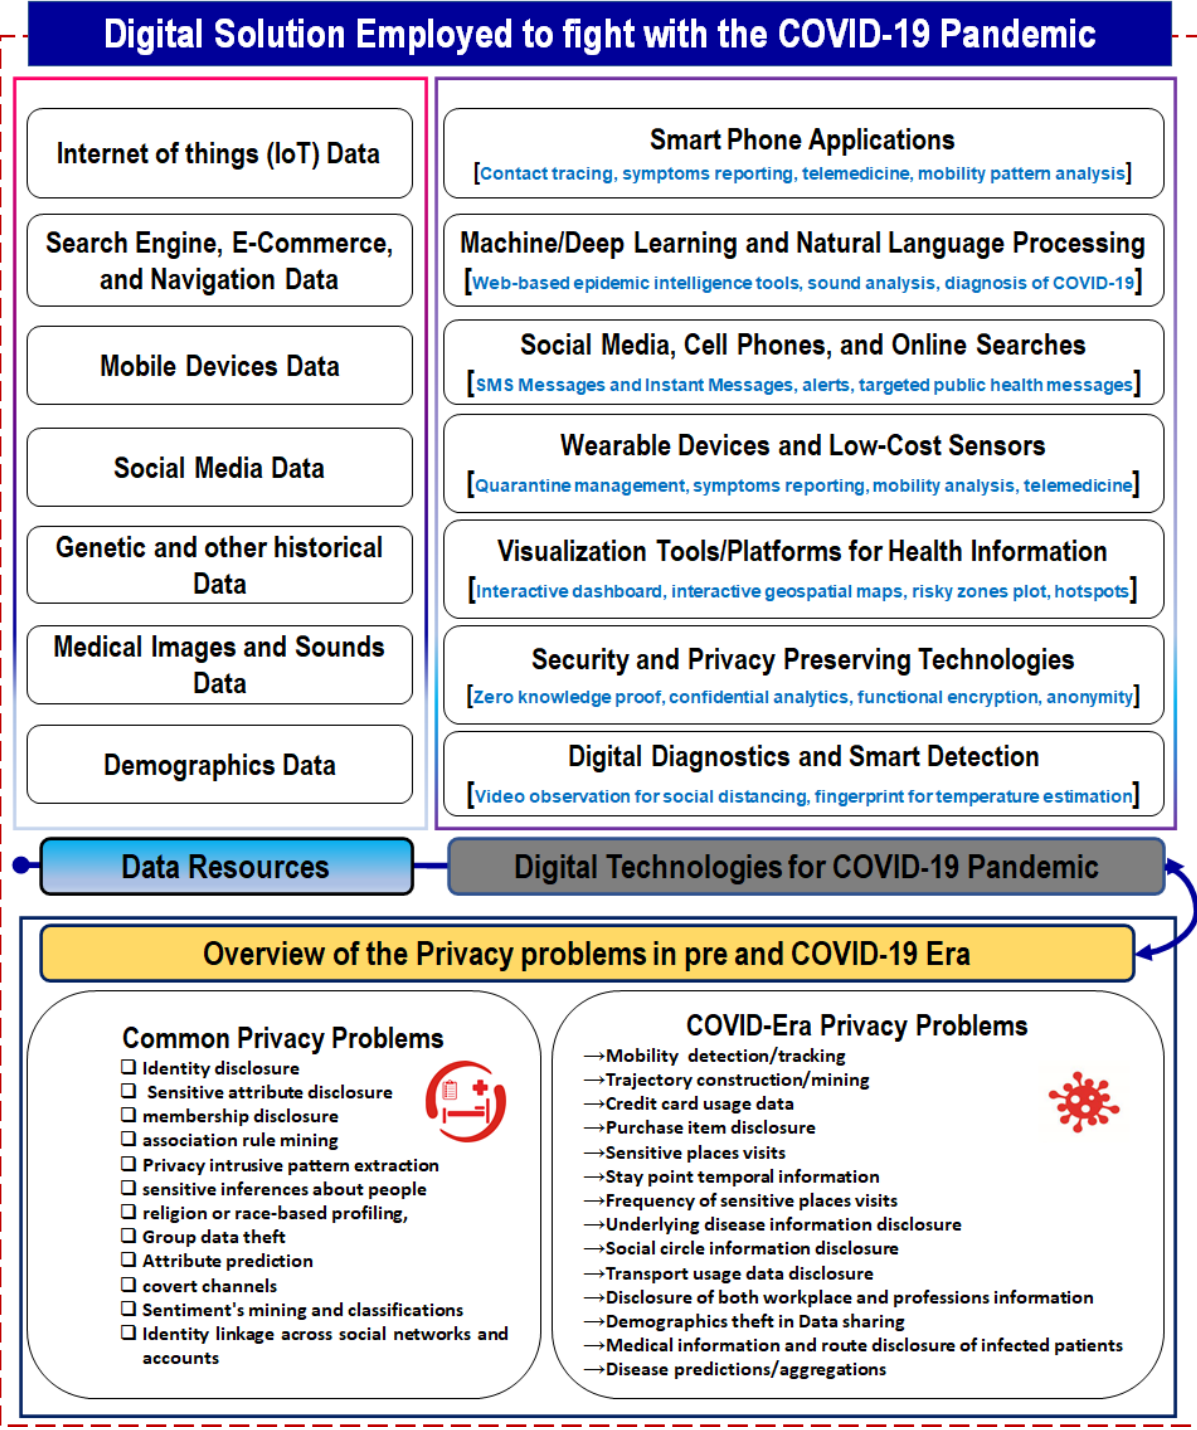
Figure 1. Conceptual overview of digital solutions and privacy issues in the COVID